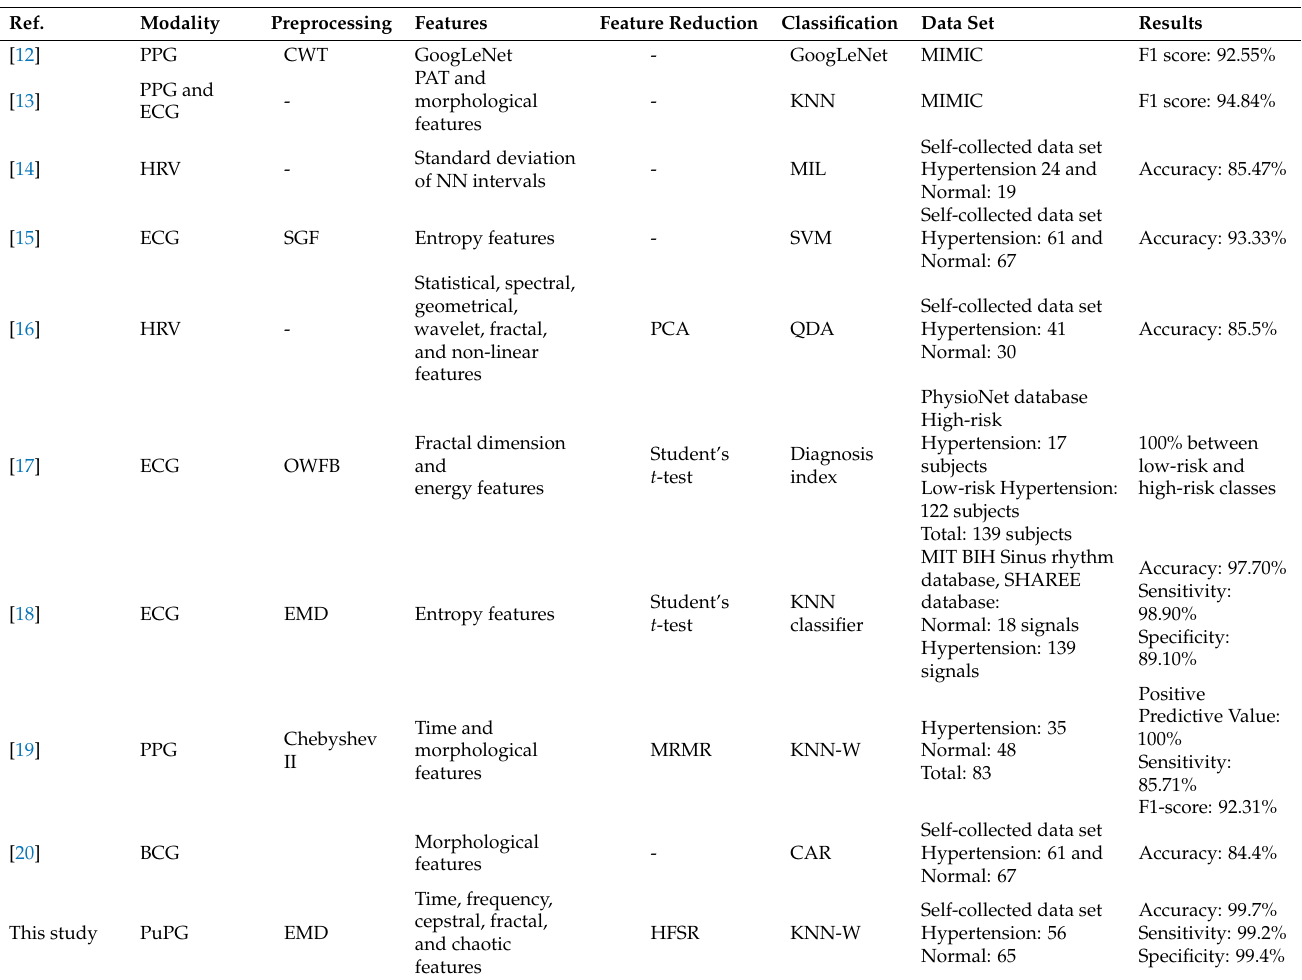
Table 16. Comparison with previous